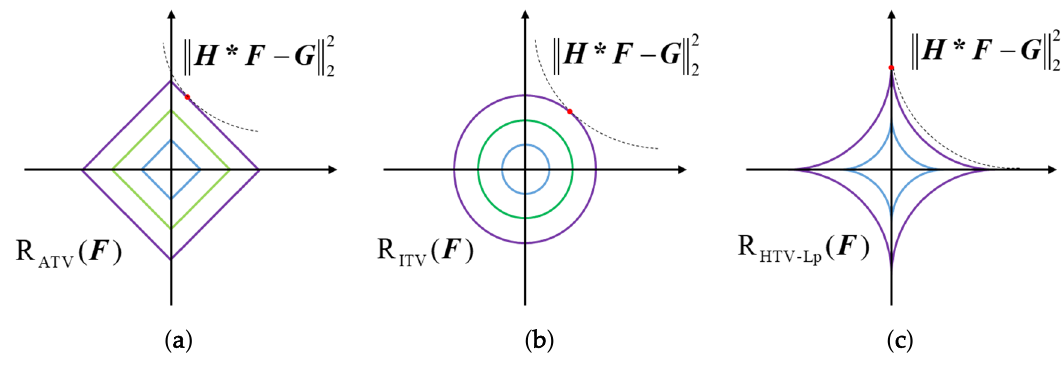
Figure 1. Contour maps of di ff erent norms. ( a ) L1-norm, ( b ) L2-norm, ( c ) Lp-pseudonorm (0 ≤ p ≤ ).